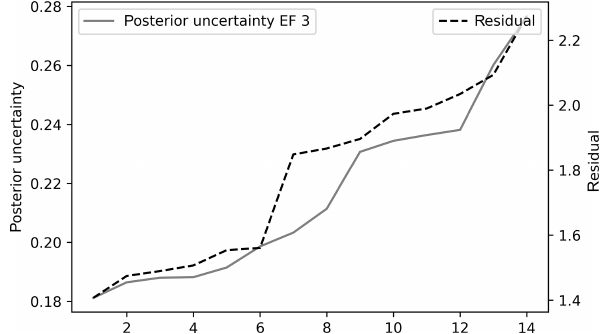
Figure 12. Increase in posterior uncertainty (1 σ of unitless scaling factor) in the industrial emission factor (EF 3) and absolute mean residual of CO 2 (in ppm) from highest- to lowest-ranked